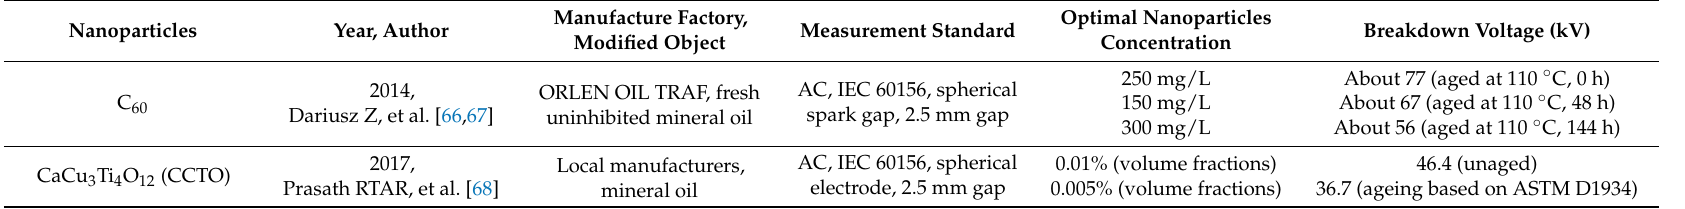
Table 1. Breakdown voltages of mineral insulation oil modified with C 60 and